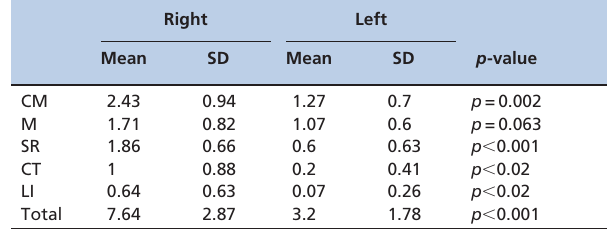
Table 2 - Means and standard deviations of histological